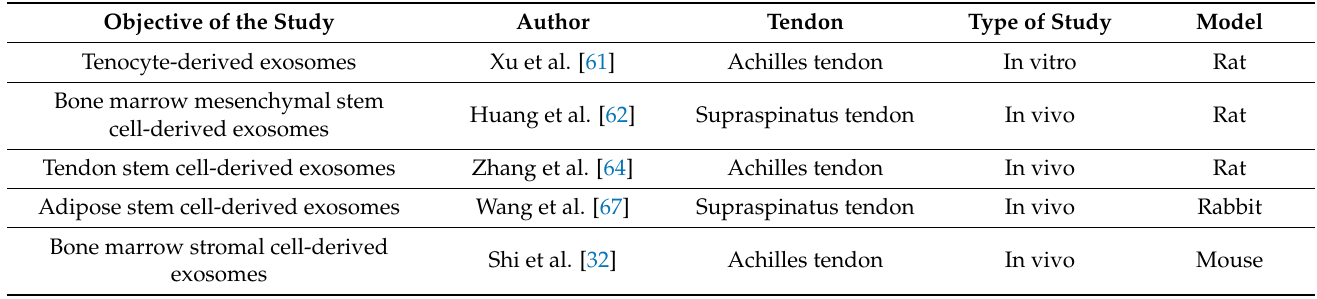
Table 3. Summary of studies using exosomes for tendon repair.